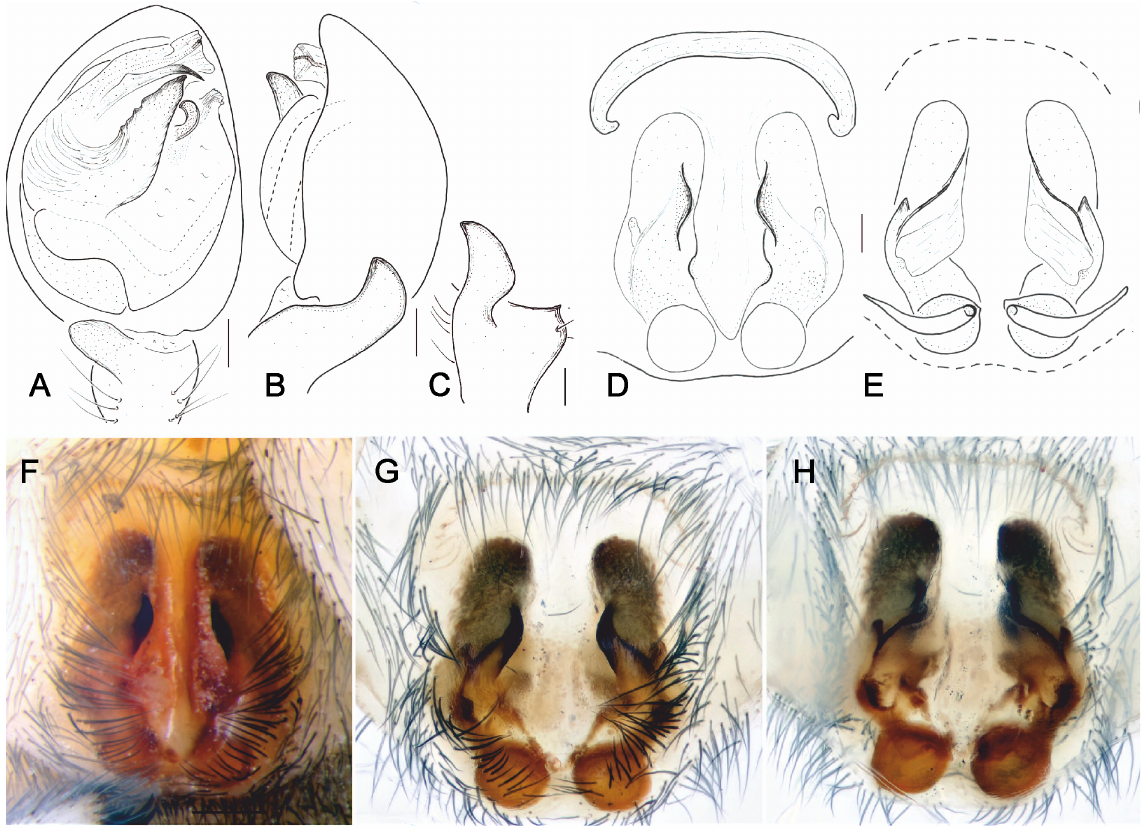
Fig. 14. Haplodrassus qashqai sp. nov. (A–C= holotype, ♂, MHNG; D–H = paratype, ♀ from Lorestan Province, MHNG). A–B . Palp, ventral and retrolateral views. C . Tibial apophysis, retrodorsal view. D–E . Epigyne, ventral and dorsal views. F . Intact epigyne, ventral view. G–H . Macerated epigyne, ventral and dorsal views. Scale bars: 0.1